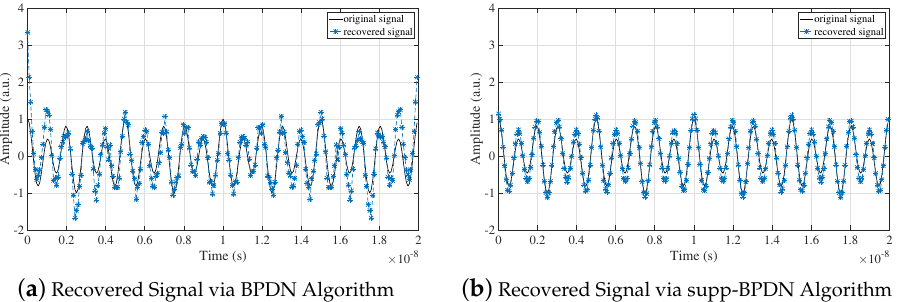
Figure 8. Comparison of original and reconstructed signals using BPDN and supp-BPDN algorithms. Frequencies of signal were 1 GHz and 600 MHz; sampling rate was 500 MHz. ( a ) Signal recovered by BPDN. ( b ) Signal recovered by